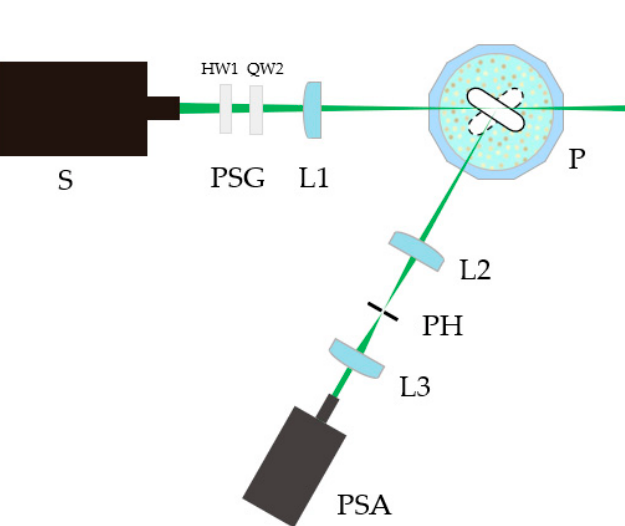
Figure 1. The schematic diagram of the experiment setup. Scattering happens once microalgae pass the scattering volume which is the intersec- tion volume of the optical systems of the illuminating path and receiving path [18]. Then, the scattered light is received at the backward 120 ◦ , and this angle has been proven to be sensitive to the microstructure of microalgae [8]. Subsequently, the scattered light passes through the lenses (L2 and L3), and the pinhole (PH) of 100 µ m, so as to collimate the light and confine the size of the scattering volume to 100 µ m. Then, the measurement of individual microalgae can be realized if the concentration is lower than 10 5 cells per mL. The collimated light after L3 can be analyzed by the polarization state analyzer (PSA), to finally get the Stokes vector S [23], as Equation (1),